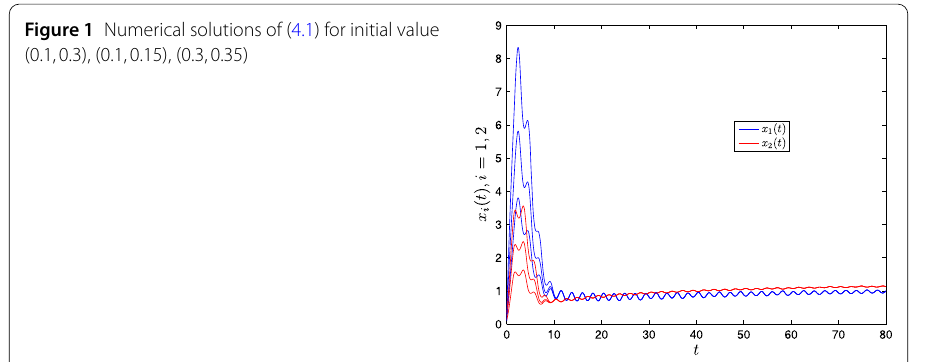
Figure 1 Numerical solutions of (4.1) for initial value (0.1,0.3), (0.1,0.15),